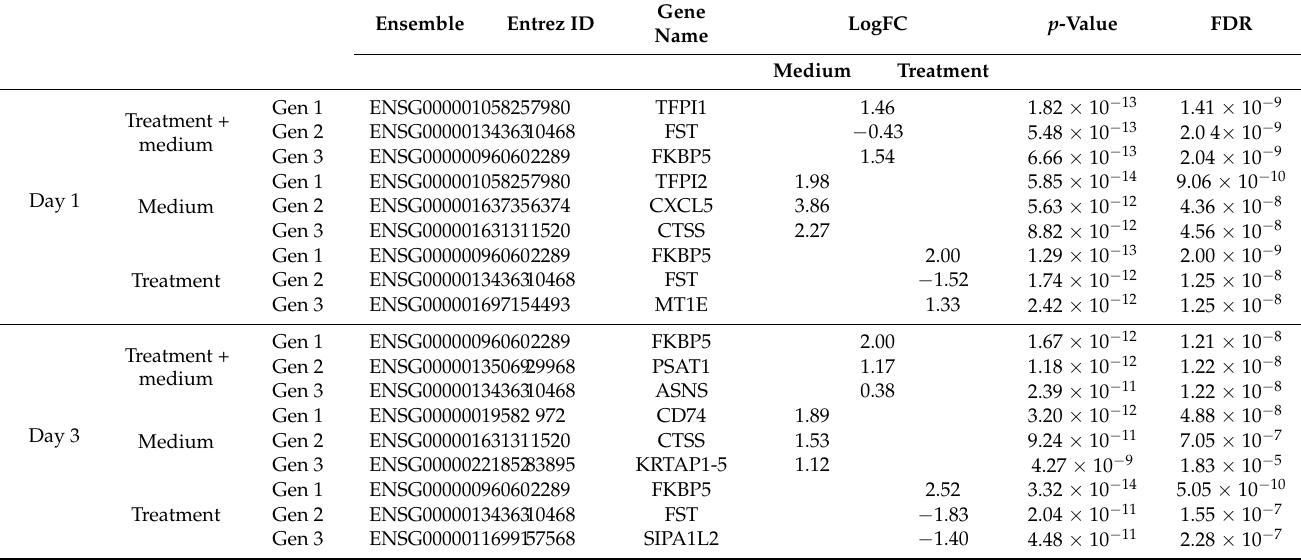
Table 3. Top three differentially expressed genes for the effect of growth medium, AA/retinol treatment, as well as the combined effect of inflammatory medium and AA/retinol treatment. Effects have been adjusted for the influence of different probands. LogFC = log Fold Change, LogCPM = log counts per million. Correction for multiple testing was performed with the Benjamini–Hochberg method, significance level was set to FDR <